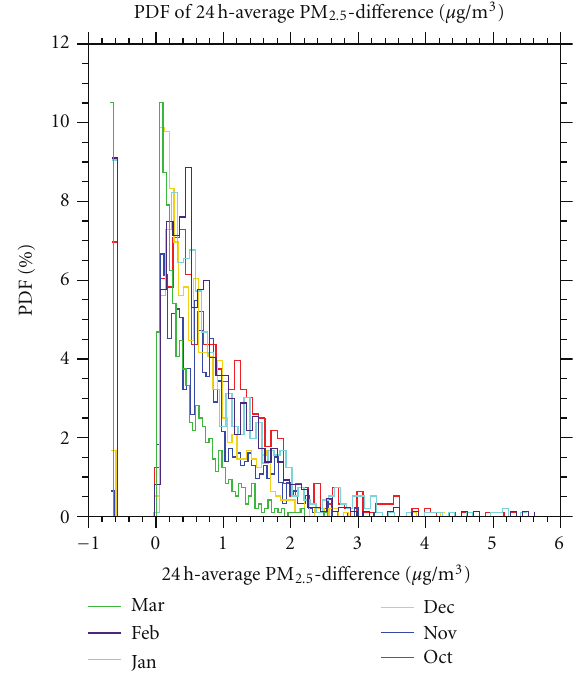
Figure 4: Population distribution of 24h-average PM 2 . 5 di ff erence in the nonattainment area as obtained for WSR in each month. The occurrences of all 24h-average PM 2 . 5 di ff erences < 0.0 μ g . m − 3 were summed up and their distribution is shown on the left most of the x